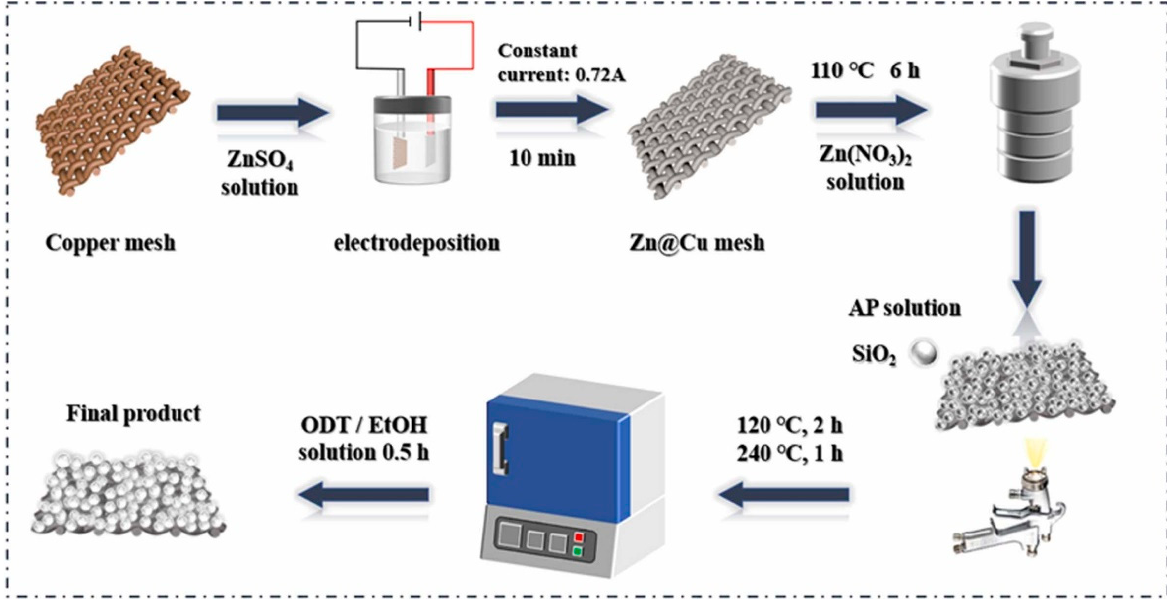
Figure 5. Schematic illustration for the fabrication process of the Janus membrane. Reprint with permission from Ref. [59] . Copyright 2022, Elsevier.